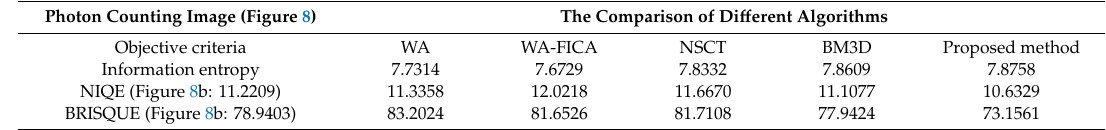
Table 3. Comparison of di ff erent algorithms’ denoising e ff ects from Figure 8. Photon Counting Image (Figure